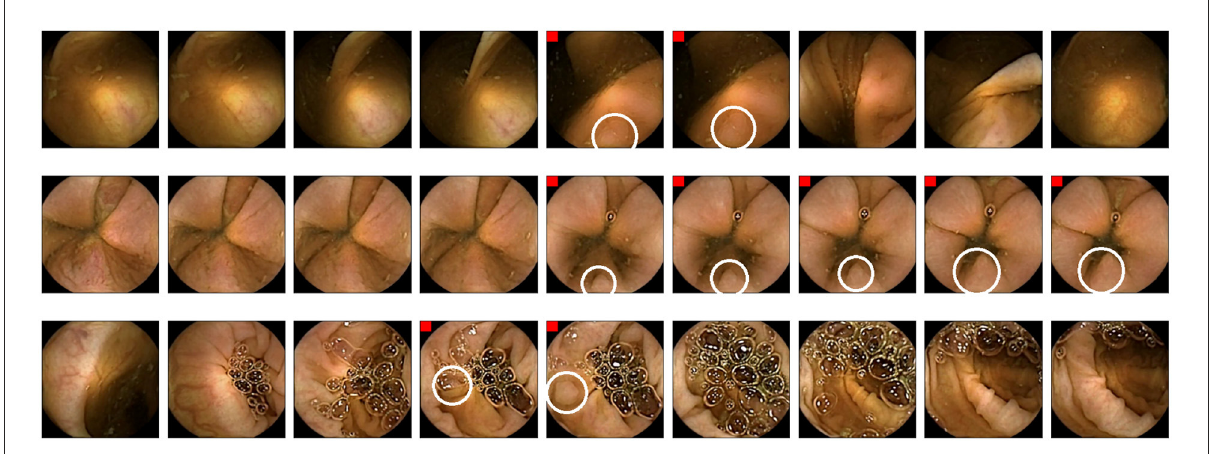
FIGURE7 Example of polyps missed in RAPID experiments. Polyp frames are tagged with a red square. Polyps are circled in